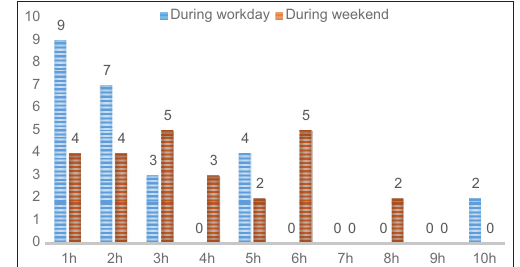
CHART 16. Time spent in a sedentary position. (During a work- day - During the